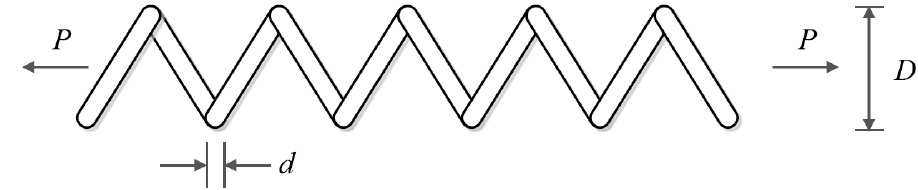
Figure 11. Schematic of tension/compression spring design.